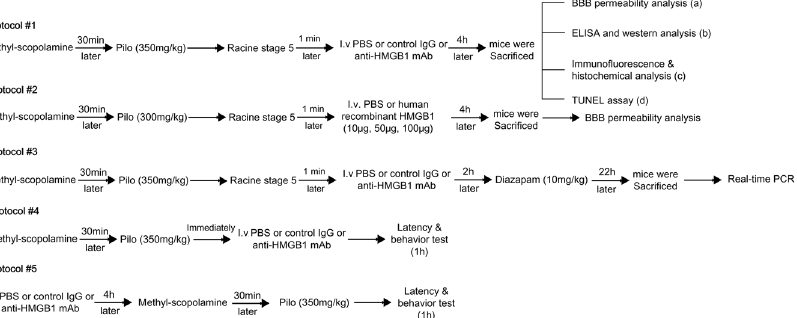
Figure 9. A schematic of the experimental design, drug doses and subsequent processes. Protocol #1: Racine stage 5 seizures were induced by pilocarpine which were then treated with PBS, control IgG or anti-HMGB1 mAb for 4 h, then sacrificed, and examined for the BBB permeability, the translocation of HMGB1 ( a , b , c ), and the apoptosis cells under acute status epilepticus ( d ). Protocol #2: Mice were administered 10, 50, or 100 μ g of human recombinant HMGB1 for 4 h under status epilepticus condition, then BBB permeability was determinated by Evans blue again. Protocol #3: Epileptic mice were treated with PBS or control IgG or anti- HMGB1 mAb for 24 h, then subjected to RT-PCR analyses. Protocol #4: Mice were injected with pilocarpine and either PBS, control IgG or anti-HMGB1 mAb, then immediately subjected to a seizure latency test, followed by a behavior test under 1 h post-treatment. Protocol #5: Mice were pretreated with PBS, control IgG or anti- HMGB1 mAb for 4 h before pilocarpine induction followed by behavior and latency test in 1